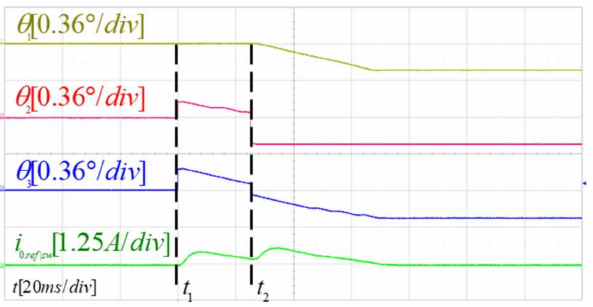
Figure 17. Carrier phases of individual inverters and the trend of the reference zero − sequence current when the phase errors occurred during control are